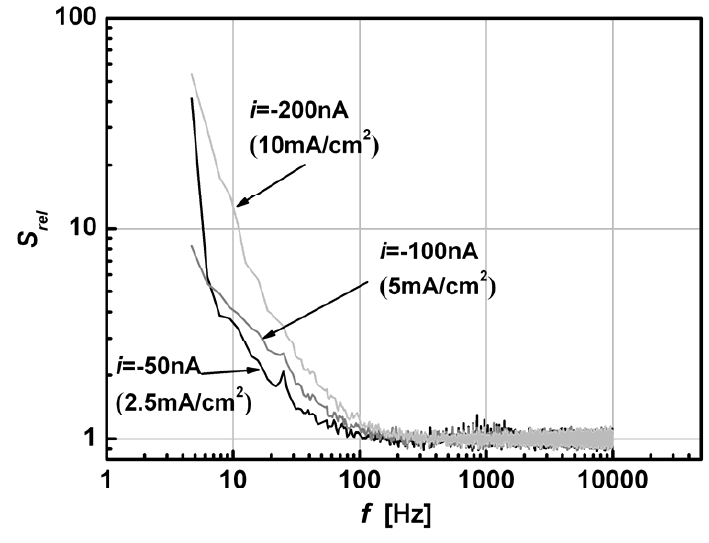
Fig. 6 Typical oscillating potential-time function in the case of Ag electrode, i = -50